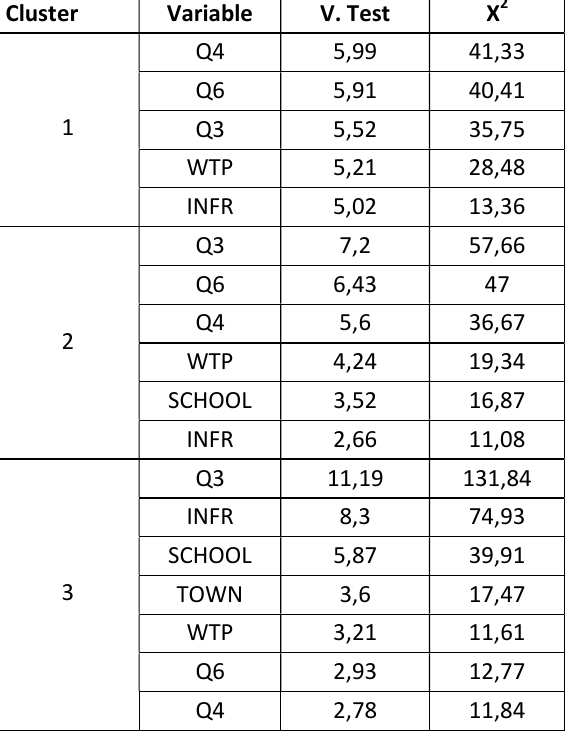
Table 6: Characterization of clusters by